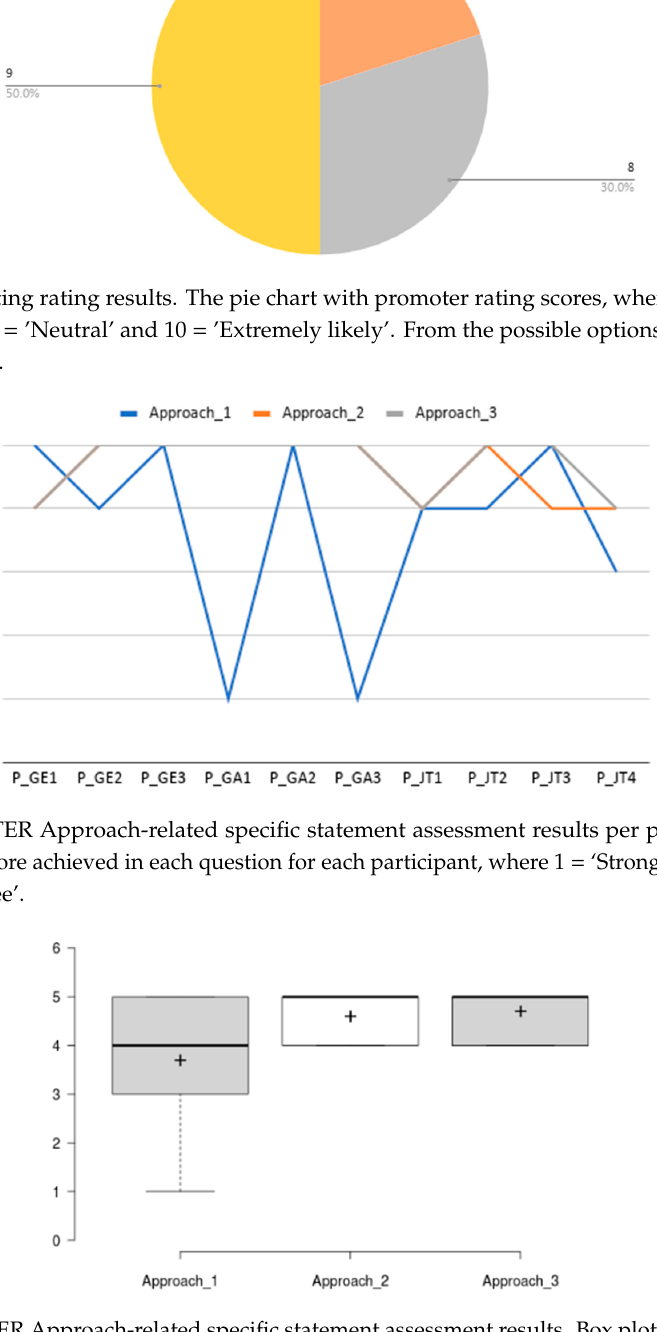
Figure 20. Promoting rating results. The pie chart with promoter rating scores, where 1 = ’Not at all likely Disagree’, 5 = ’Neutral’ and 10 = ’Extremely likely’. From the possible options, only 7, 8 and 9 values were given.